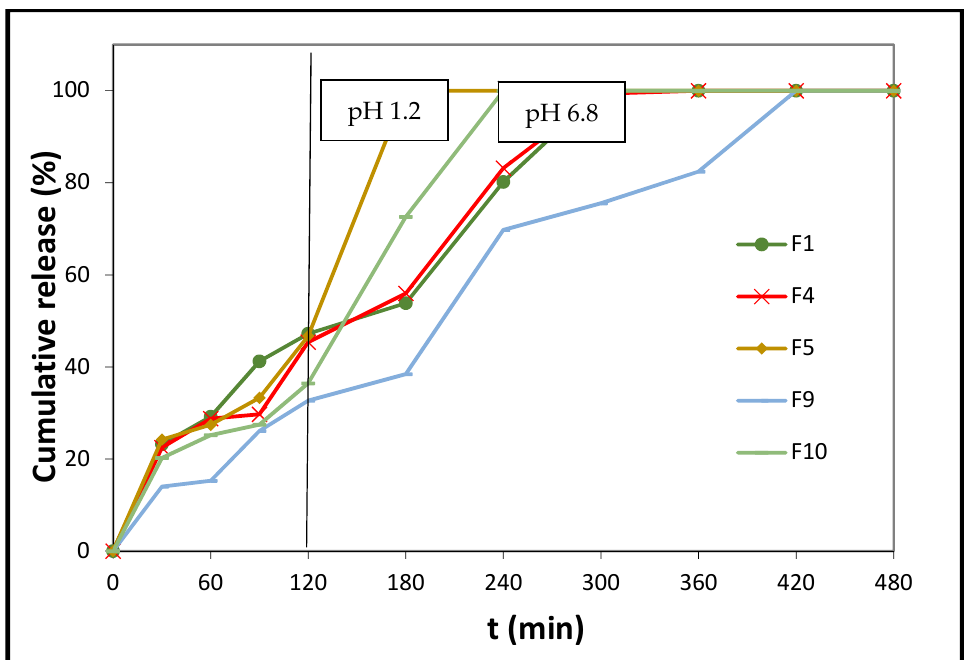
Figure 6. In vitro % release of melatonin from formulations F1, F4, F5, F9, and F10 vs. time. The results represent the mean value (n = 3, SD < 2).